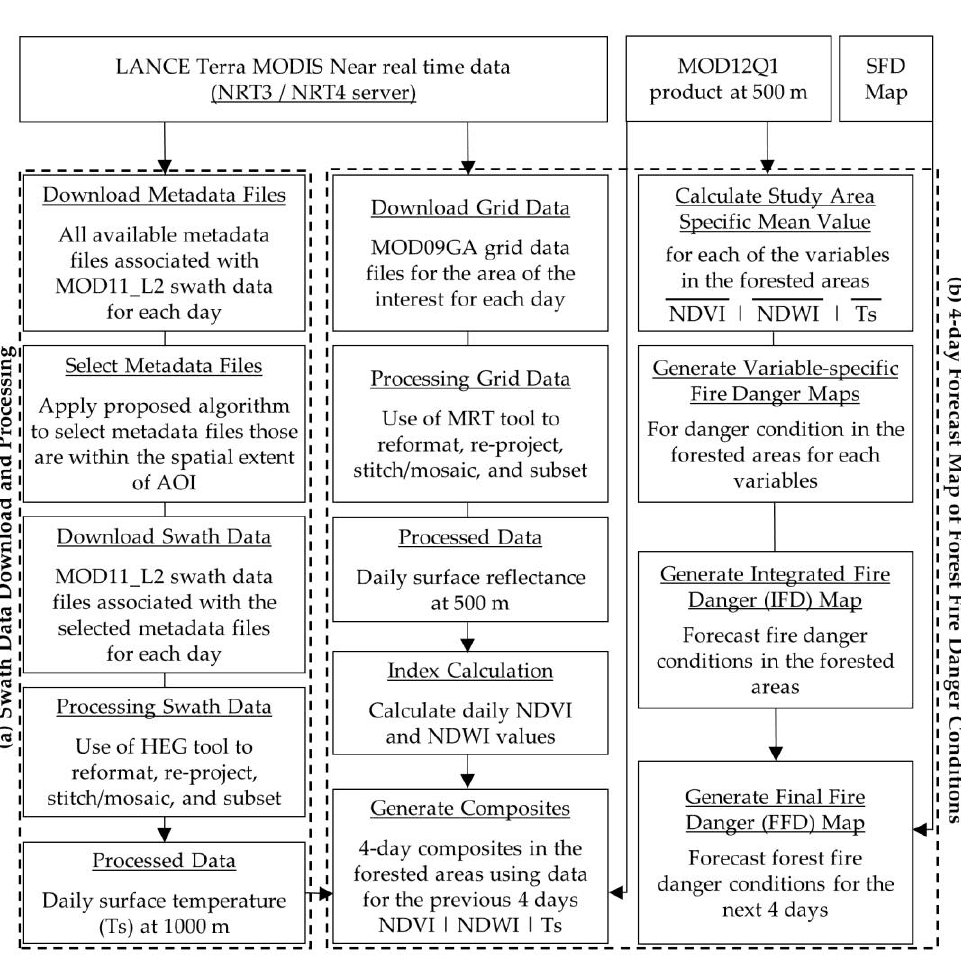
Figure 3. Conceptual diagram of download and processing of Terra MODIS NRT swath data of Ts from LANCE ( a ), and further use of the processed Ts in generating a 4-day forecast map of forest fire danger conditions ( b ).